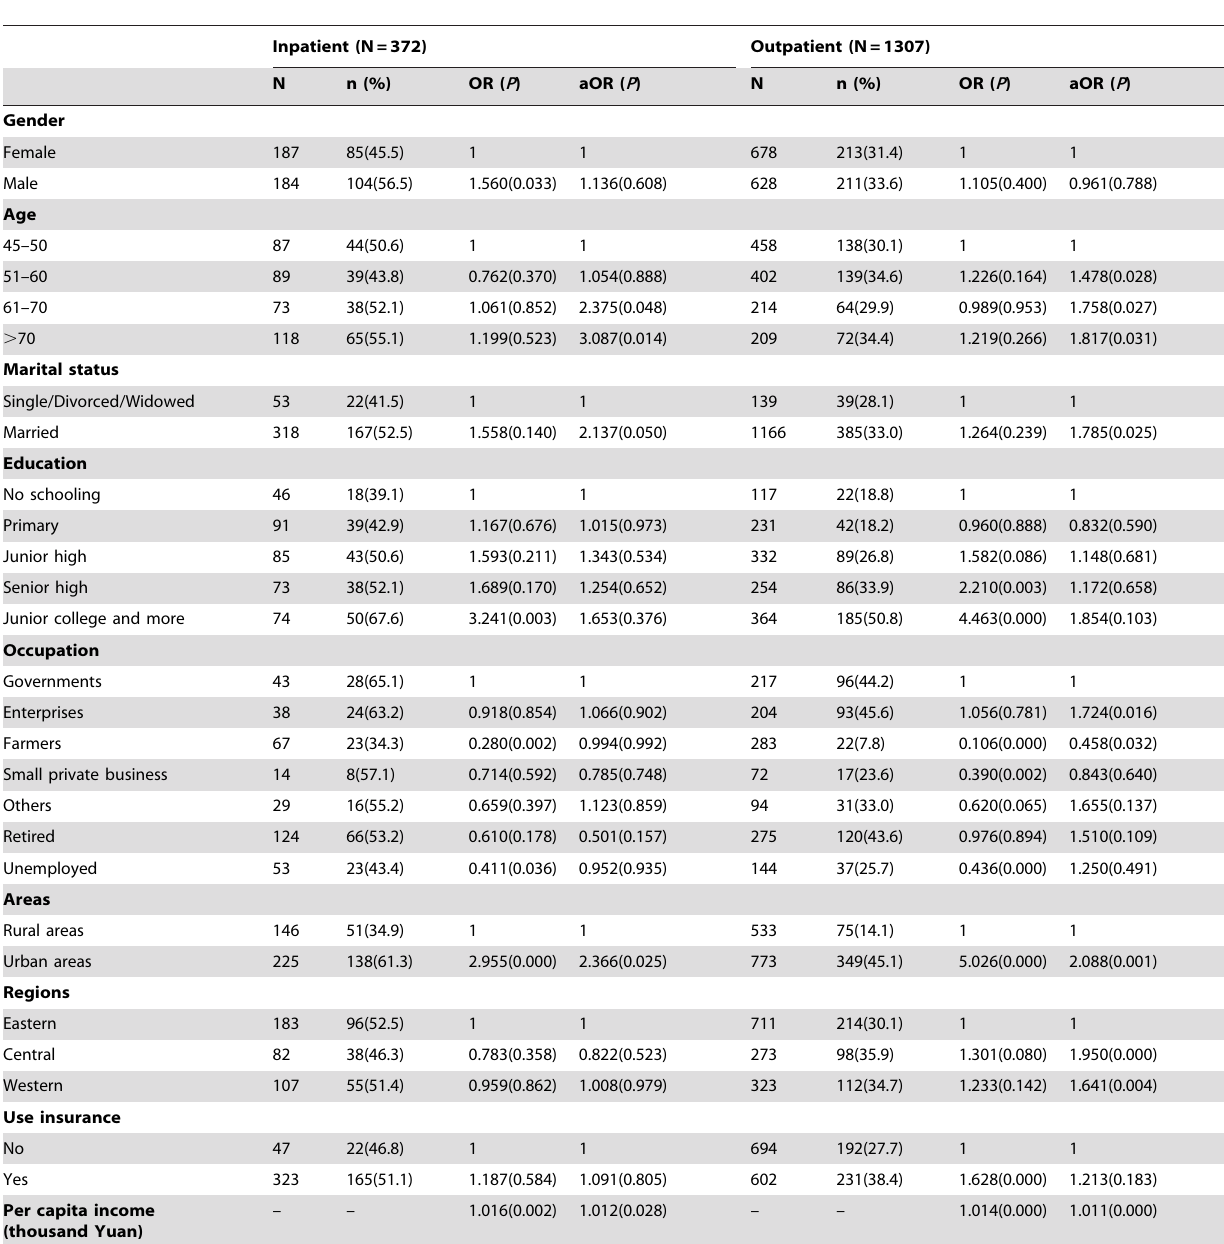
Table 3. Univariate and multivariate logistic regression analysis of the prevalence of using grade III hospital for inpatient and outpatient